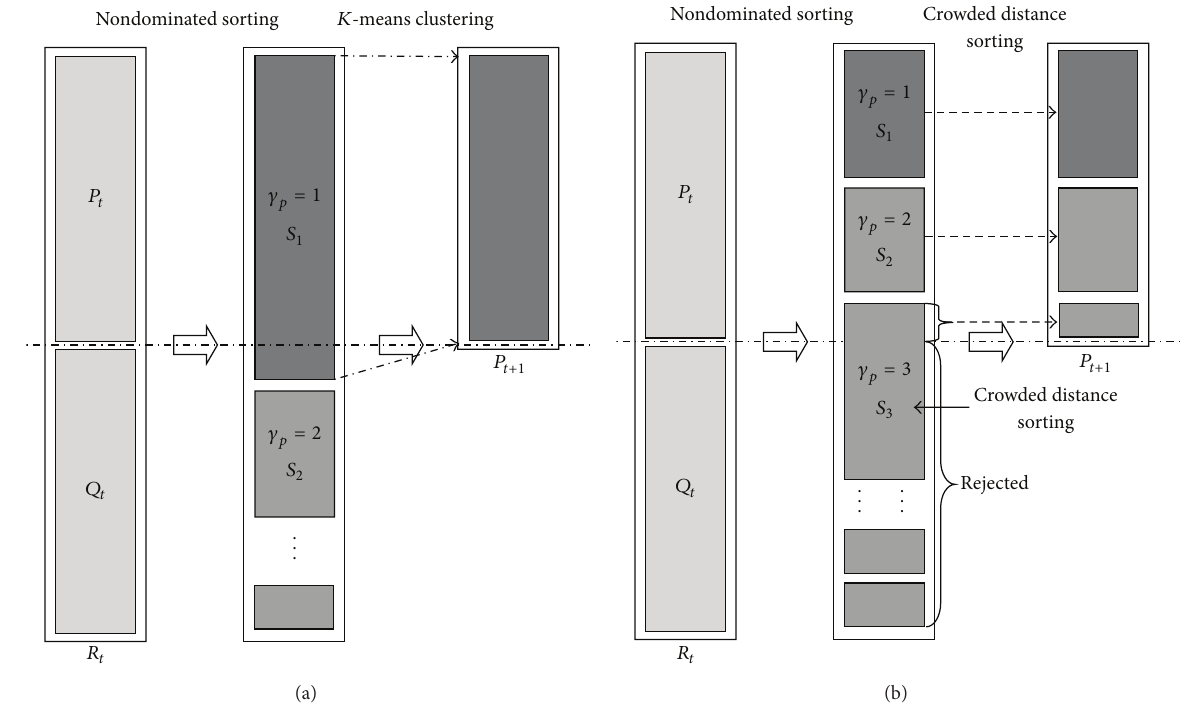
Figure 4: The procedure of generating the new population in